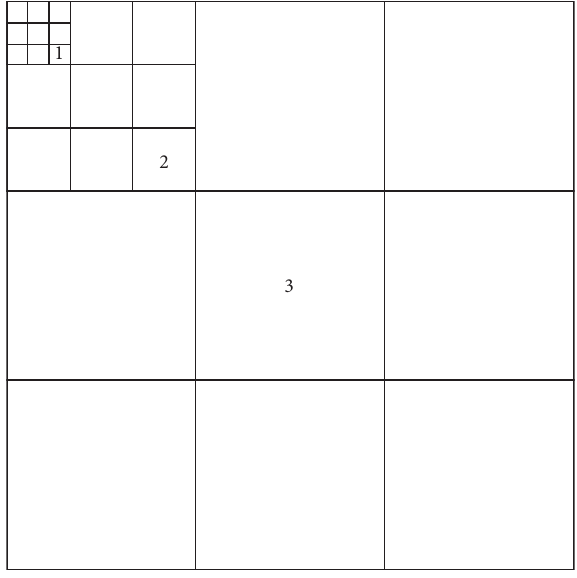
Figure 12: Renormalization of cellular